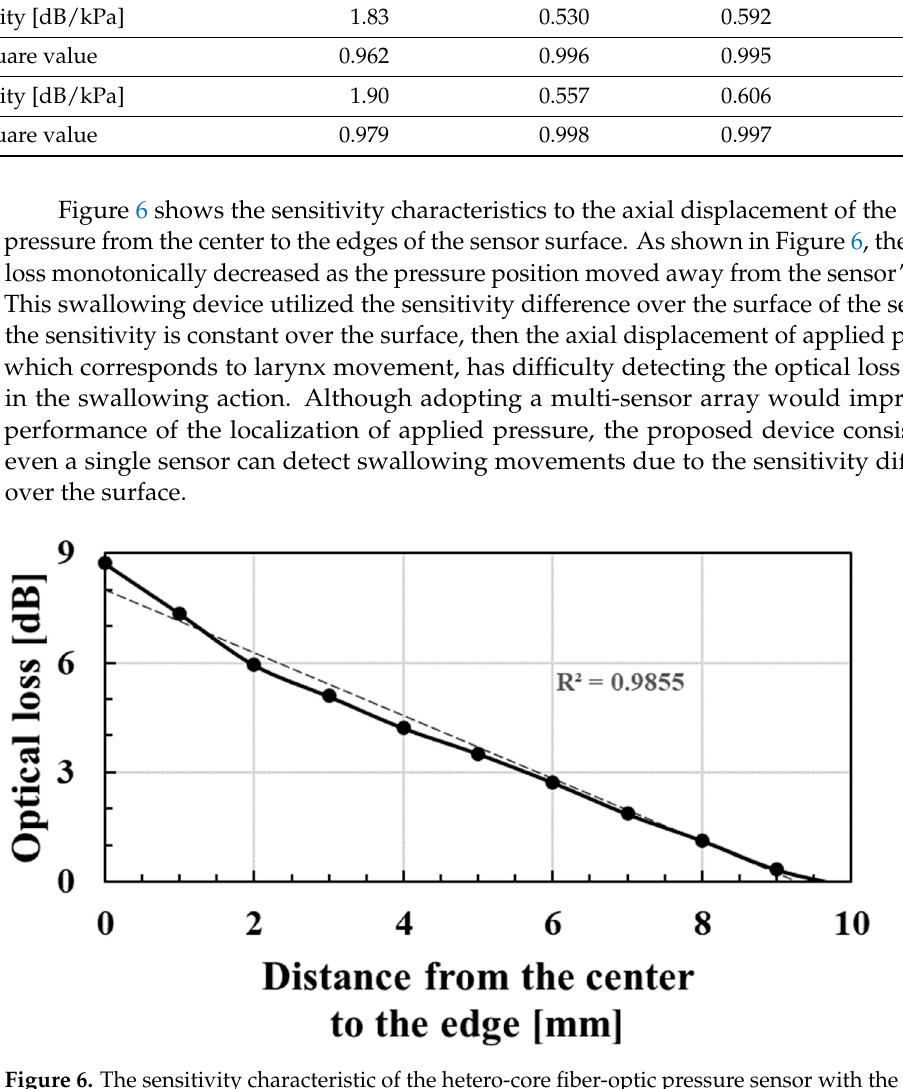
Figure 6. The sensitivity characteristic of the hetero-core fiber-optic pressure sensor with the puff and the supporting part to the axial displacement of the applied pressure from the center to the edges of the pressure sensor’s surface.